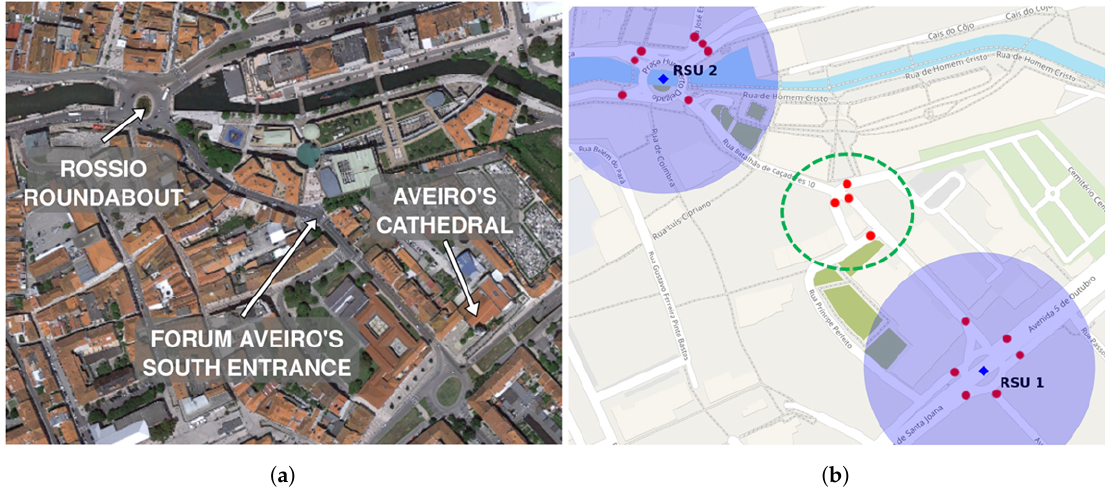
Figure 11. Mobility scenario. ( a ) Aveiro city, Portugal. ( b ) Used crosswalks (red